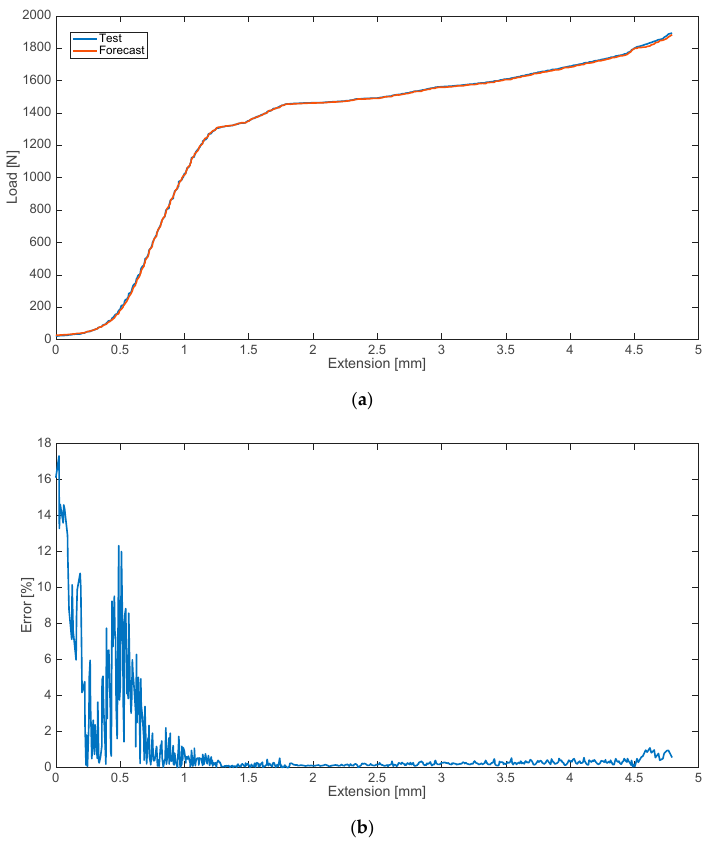
Figure 1. Strength characteristics ( a ) and error values ( b ) for 10% blood admixture.